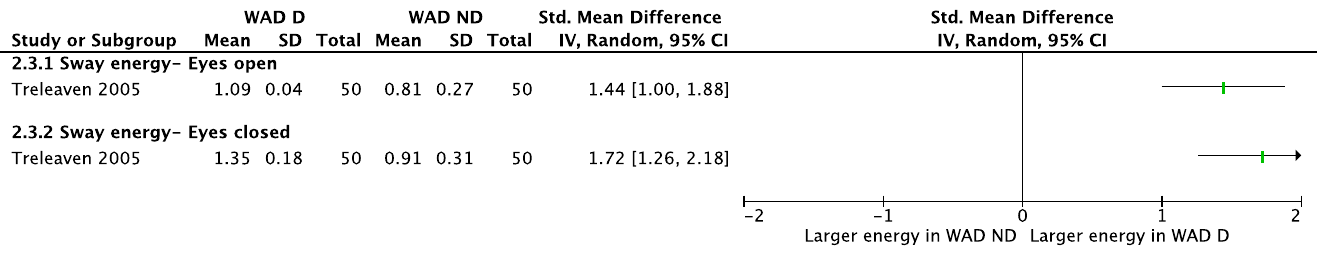
Fig 9. Forest plot, without meta-analysis, demonstrating sway energy (eyes closed) in WAD D vs. WAD ND groups. WAD D : whiplash-associated disorder presenting with dizziness; WAD ND : whiplash-associated disorder not presenting with dizziness; SD: standard deviation; IV: inverse variance; CI: confidence interval; Std: standardized.